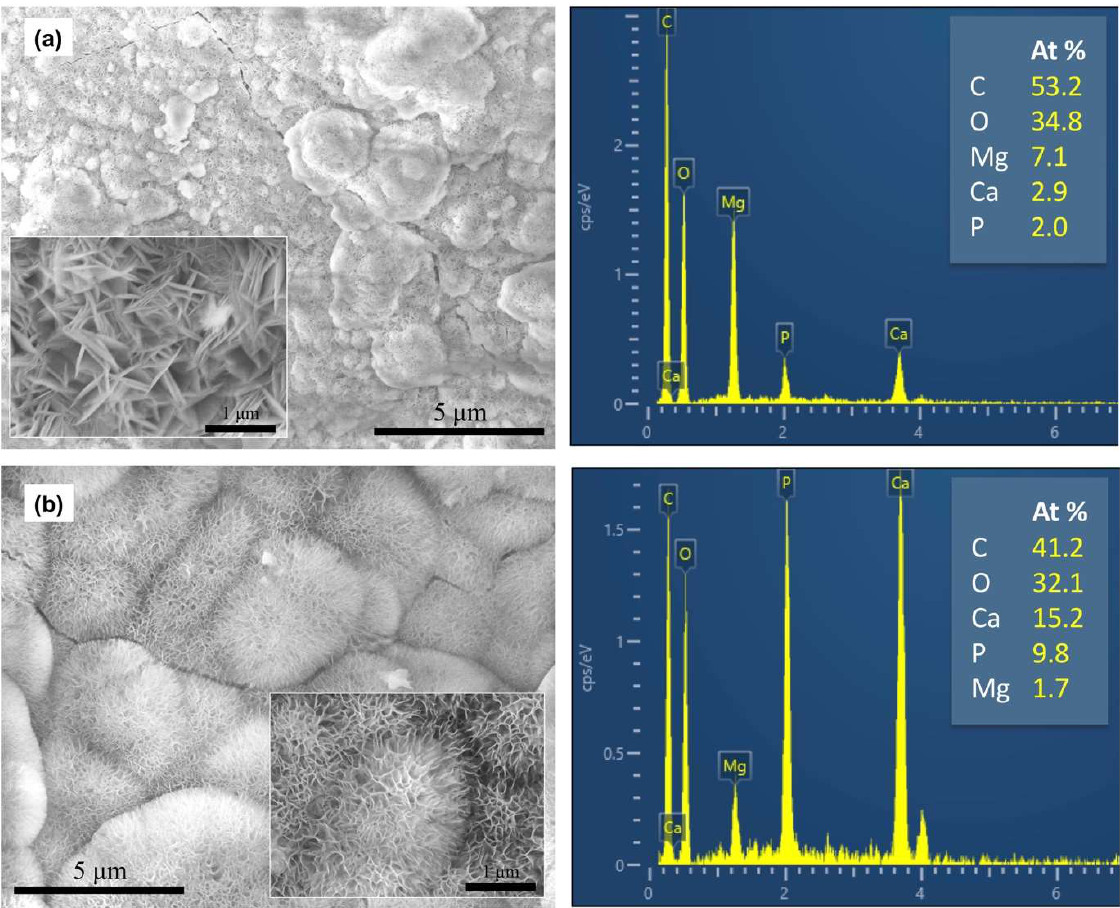
Figure 9. SEM-EDX characterization of HA-TNC-coated ZM21 after ( a ) 14 days and ( b ) 28 days of SBF immersion.